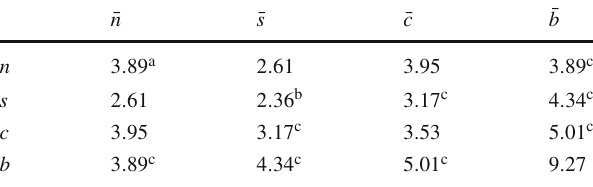
Table 8 β l of the orbital Regge trajectories. β l = β c 2 the up quark or down